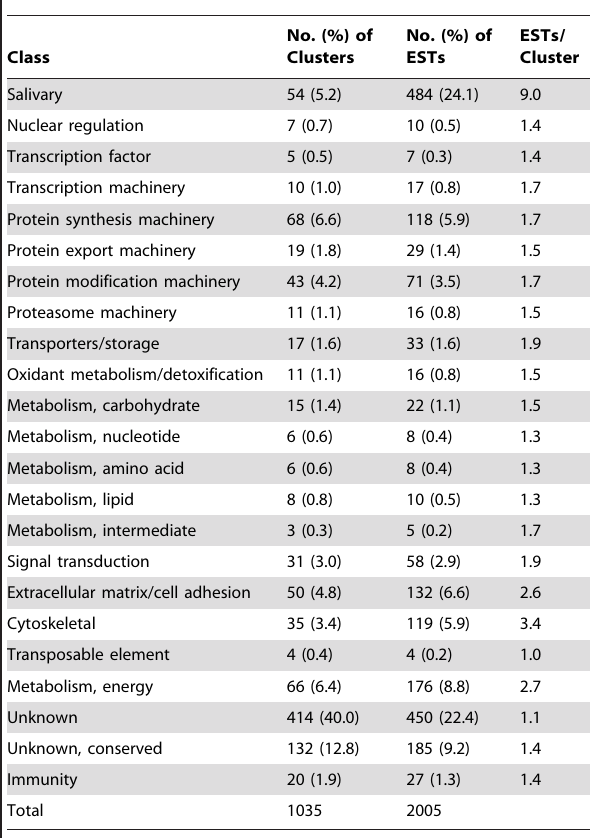
Table 1. Functional classification of An. funestus EST